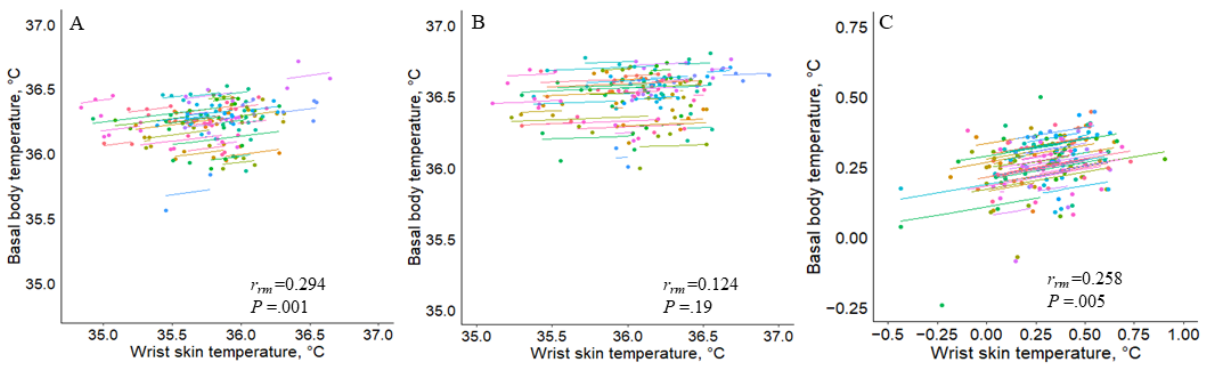
Figure 2. Repeated measures correlation (rmcorr) plots of mean wrist skin temperature and basal body temperature. A: correlation in the follicular phase; B: correlation in the luteal phase; C: correlation of between-phase temperature changes between the two